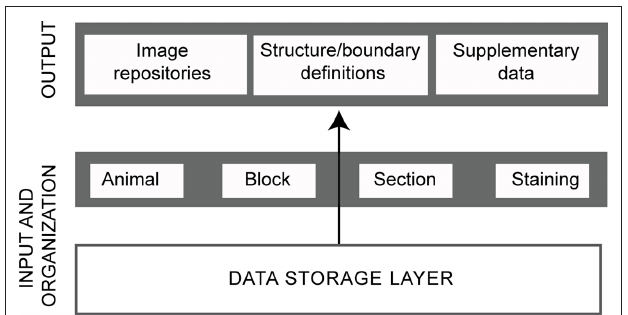
Figure 2 | Overview of database architecture. The diagram shows the logical three-layer architecture employed for the database application with main entities indicated. The data storage layer consists of the actual database holding persistent data and tables. The middle layer provides process management necessary for display of data in the presentation layer. The presentation layer (top) provides the user interfaces for the three atlas entities.